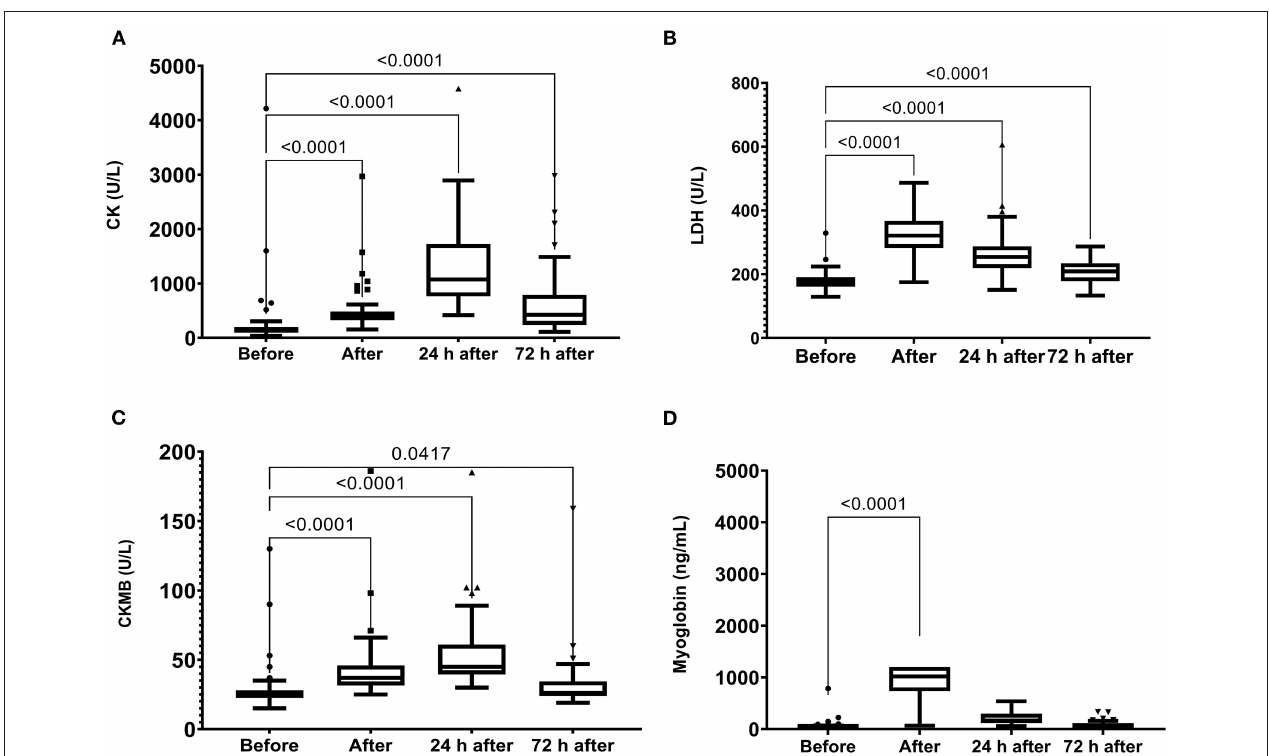
FIGURE 1 | Creatine kinase (CK) (A) , lactate dehydrogenase (LDH) (B), Creatine kinase MB (CKMB) (C) activities and myoglobin (D) plasma levels immediately after, 24h after, and 72h after the race. Creatine Kinase, CK, Lactate Dehydrogenase, LDH. The values are presented as minimum, maximum, median, and outliers of 53 runners (Box plot,